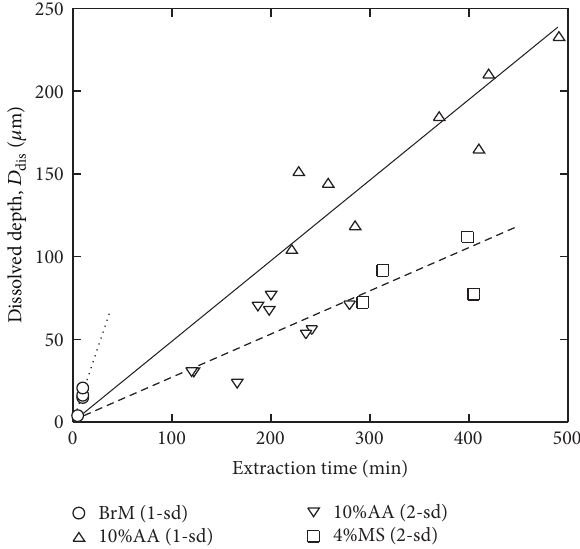
Figure 3: Dissolved depth of metal samples during one-side (1-sd) and two-side (2-sd) chemical and electrolytic